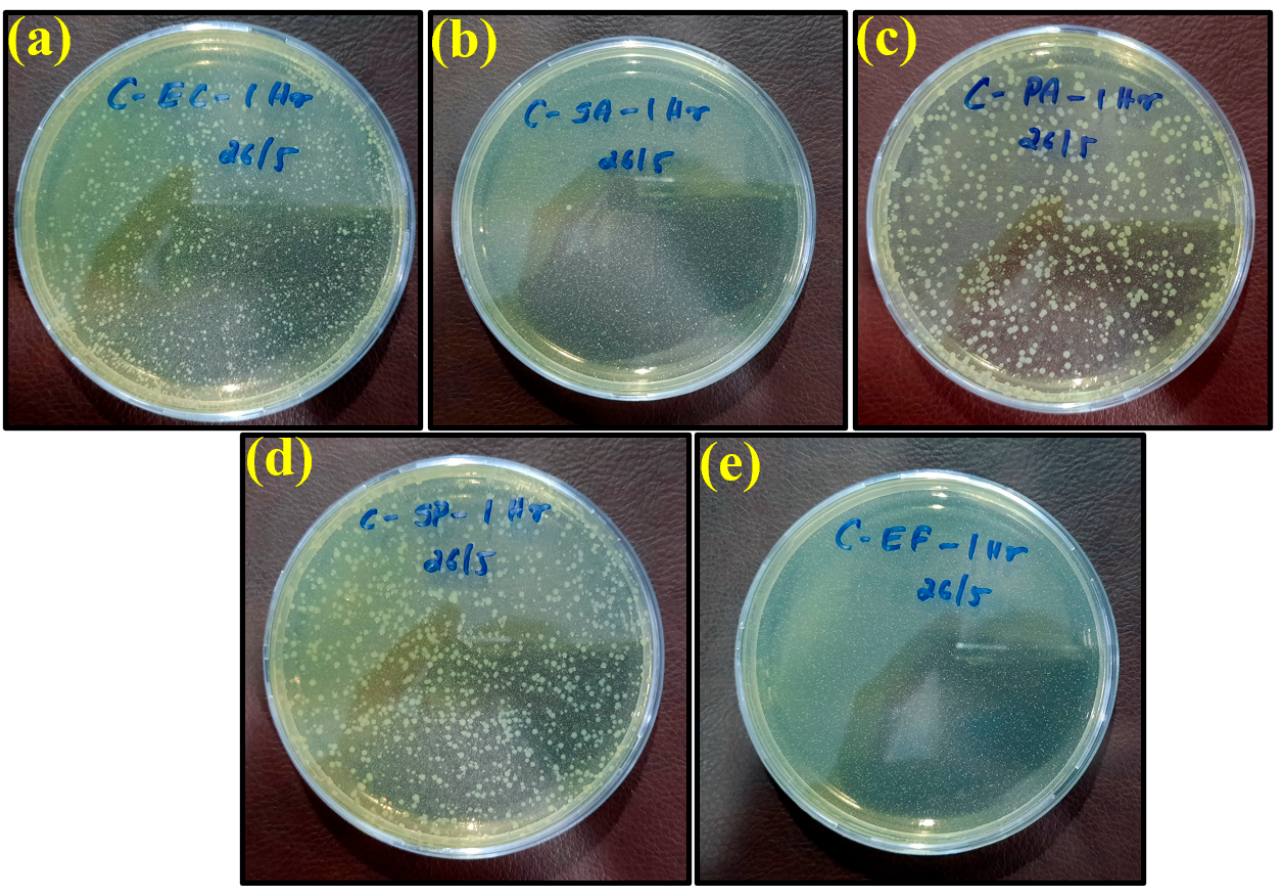
Figure 6. Images of remaining bacteria on the control surface after cultivation for 1 h: ( a ) E. coli ; ( b ) S. aureus ; ( c ) P. aeruginosa ; ( d ) S. Poona; ( e ) Enterococci .